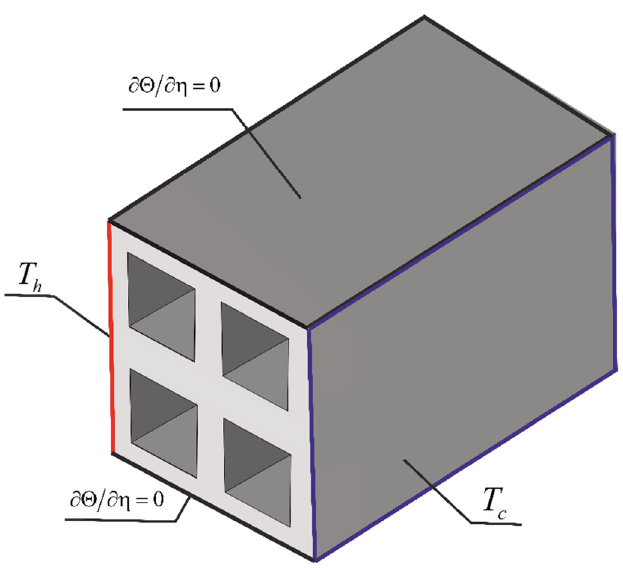
Figure 1. A schematic of the hollow brick.